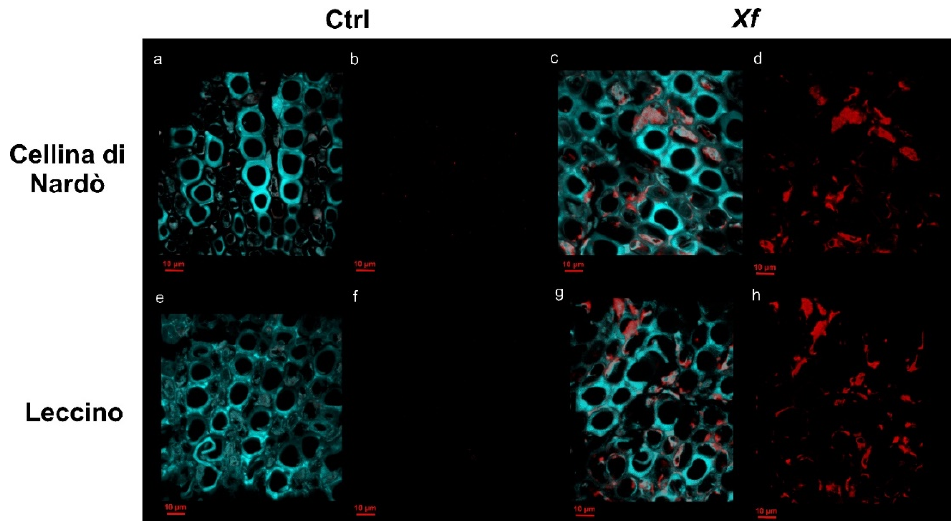
Figure 1. Confocal microscopy images showing the Xylella fastidiosa ( Xf ) colonization of xylem vessels by fluorescence in situ hybridization (FISH). Cyan: plant tissue autofluorescence; red: signal of the Xf -specific Cy5-labeled KO210 FISH probe; a , c , e and g : overlap of cyan and red signals in Cellina di Nardò and Leccino control (Ctrl), and Xf -infected plants ( Xf ); b , d , f and h : exclusively the red signal of the Xf -specific FISH probe.